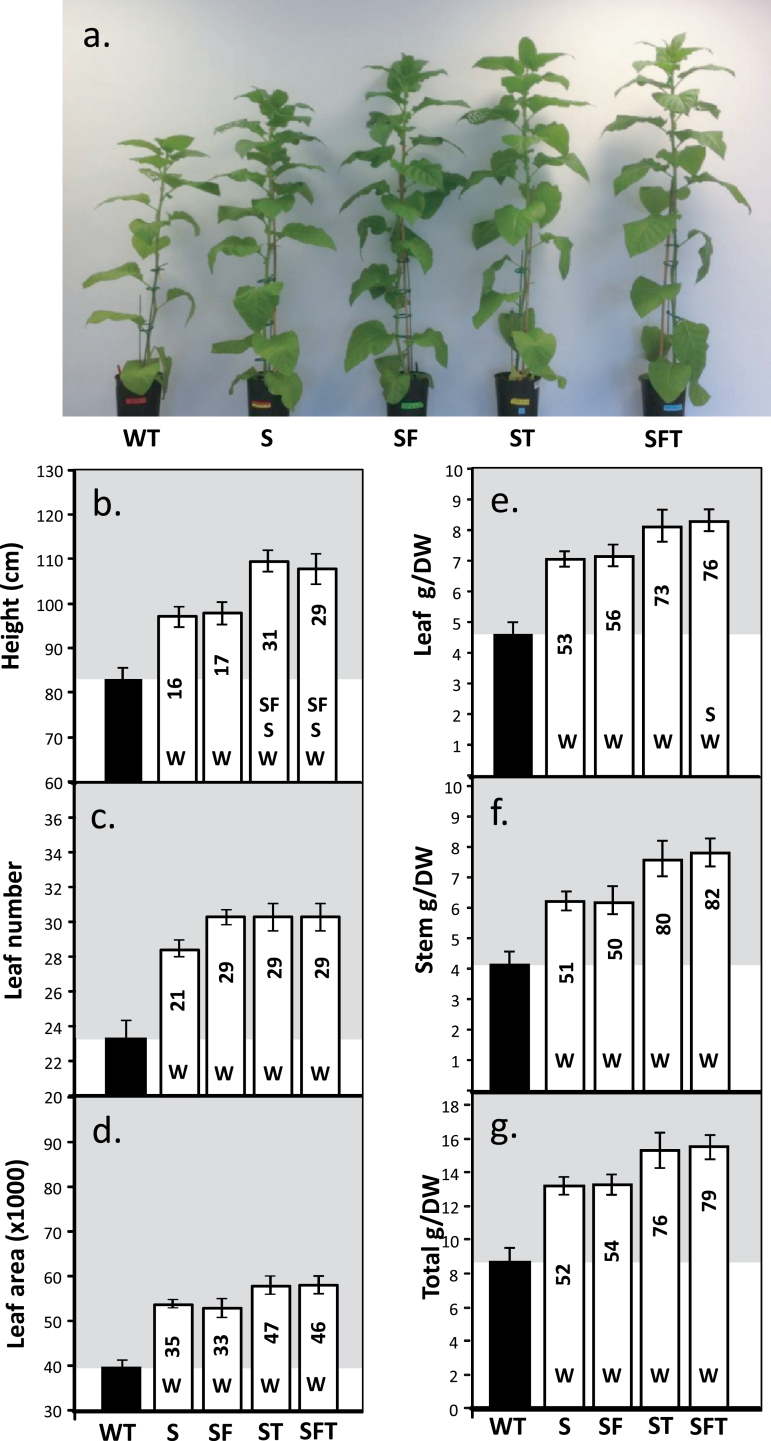
Growth analysis of WT and transgenic plants grown in low light in the greenhouse. Plants were grown for 2 weeks at 130 μmol m–2 s–1 light intensity in long days (12/12h days) before being transferred to the greenhouse and supplemented light (16/8h days), at a maximum 200–350 μmol m–2 s–1 light intensity for an additional 5 weeks (7 weeks in total). Plants were harvested when the first sign of flower development became apparent. (a) Appearance of plants after 7 weeks. Lines over-expressing SBPase (S), SBPase and FBPA (SF), ictB (T), SBPase and ictB (ST), and SBPase, FBPA, and ictB (SFT) are represented. (b) Plant height, (c) leaf number, (d) leaf area, and (e–g) biomass. Results are representative of 4–5 plants from 3–4 individual lines (12–16 plants in total). Significant differences (<0.05) are represented by capital letters indicating if each specific line is significantly different from another. Lower case italic lettering indicates lines that are just below significance (>0.05 and <0.1). The percentage increases over the wild type are indicated.